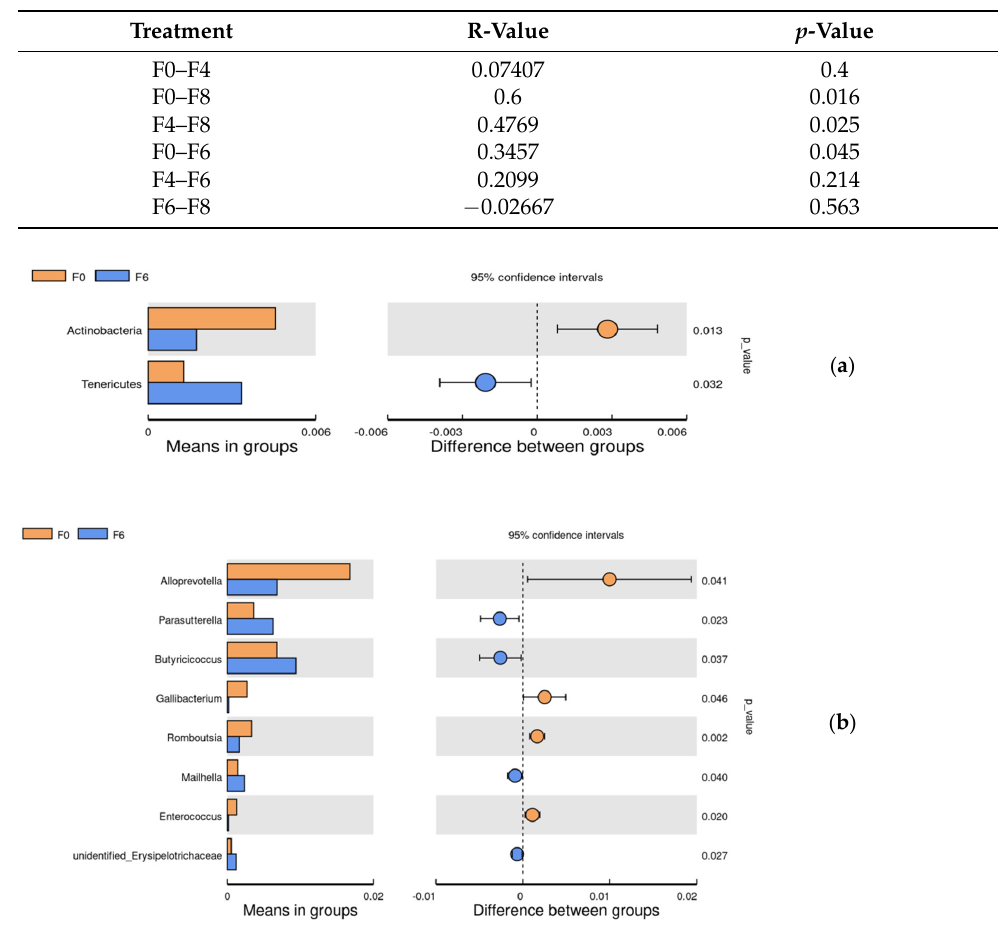
Figure 4. The phylum ( a ) and genera ( b ) differentially abundant between F0 and F6 in the cecal by t-test analysis. F0, basal diet; F6, 6% fermented mixed